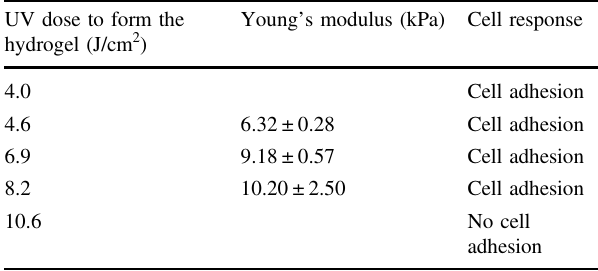
Table 2 When using different UV dosages to form the hydrogel, the cell response varied. The HA-am hydrogels were funcitonalized with RGD using a constant UV dose of 1.9 J/cm 2 UV dose to form the hydrogel (J/cm 2 )